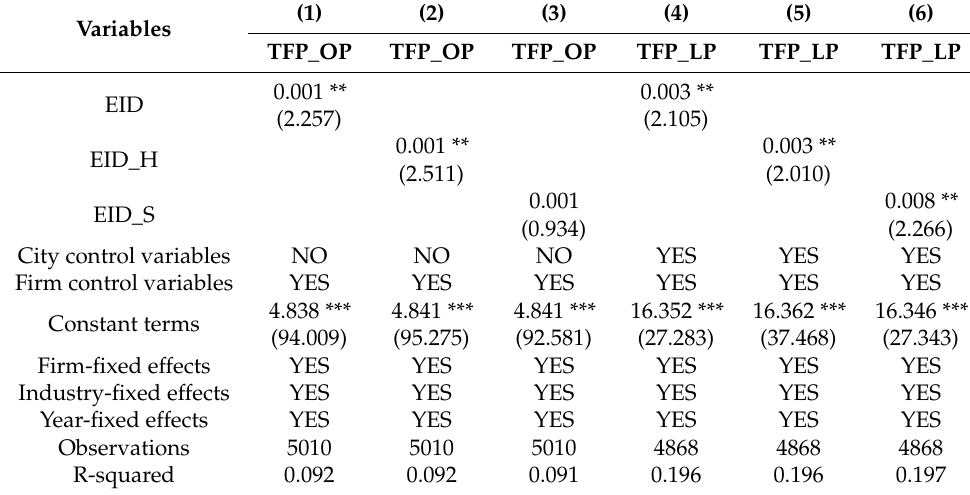
Table 3. Robustness test: replacing explained variables and adding city-level control